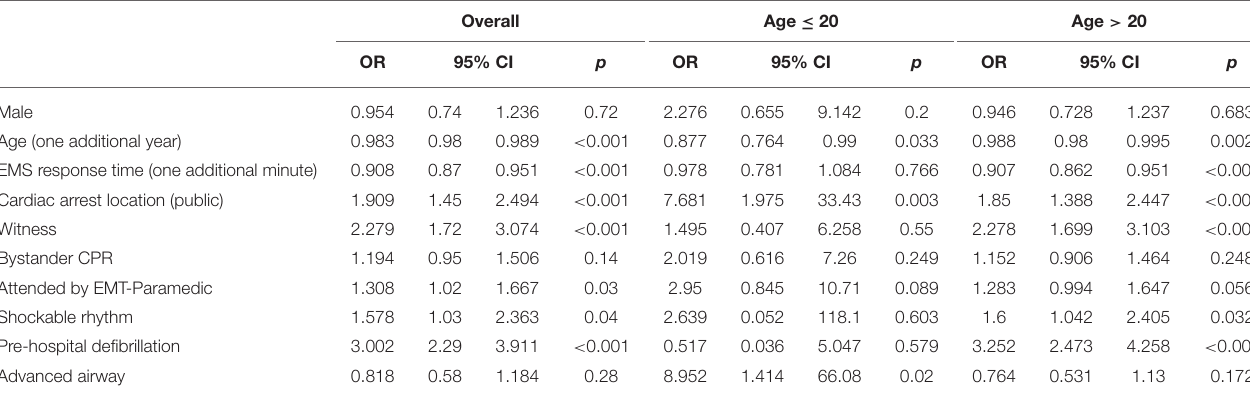
TABLE 3 | Adjusted odds ratios for survival till hospital discharge in pediatric and adult out-of-hospital cardiac arrest (OHCA).